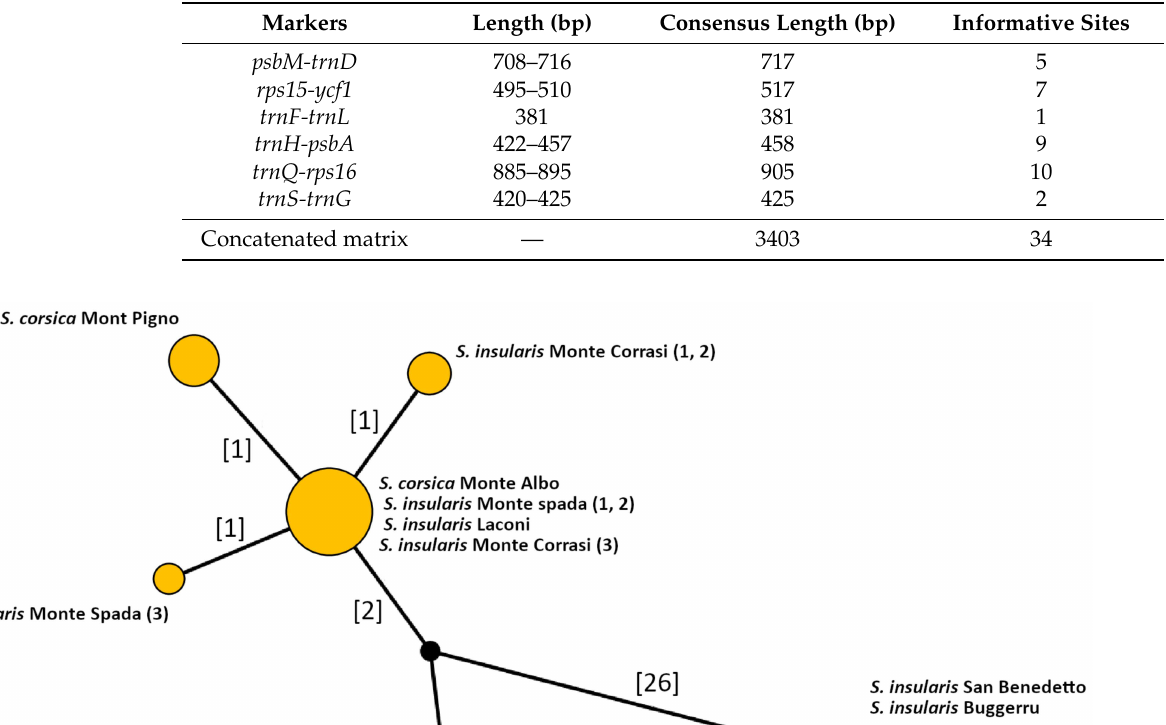
Table 5. Length (bp), consensus length (bp), and number of informative sites of the studied markers.